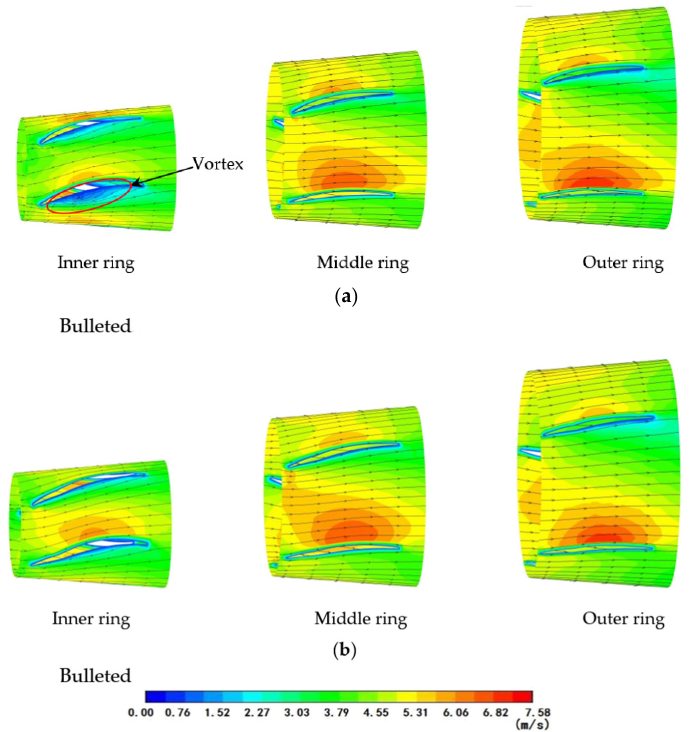
Figure 11. Flow fields of guide vane with ∆ β of 0 ◦ and − 12 ◦ , ( a ) ∆ β = 0 ◦ , ( b ) ∆ β = − 12 ◦ .